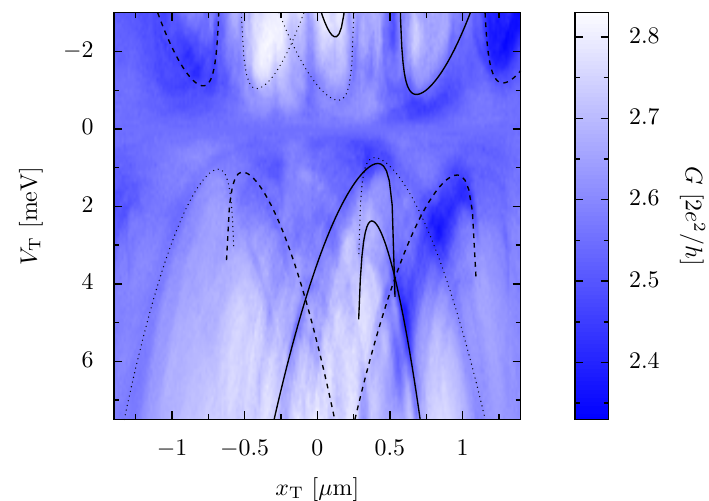
Figure 4: Classical ballistic conductance G from Eq. (2) (in units of the conductance quantum 2 e 2 / h ) as a function of position x the dashed line in Fig. 1) and strength V of Eq.